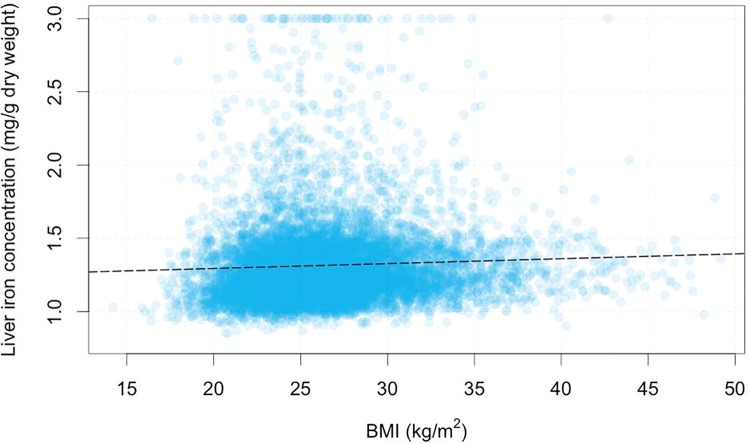
Graph showing distribution of BMI (kg/m2) in the UK Biobank population against liver iron (mg/g).Iron values above 3mg/g have been capped to 3mg/g in the plot, but not as part of the linear fit. Dashed black line shows line of best fit in univariate linear model.